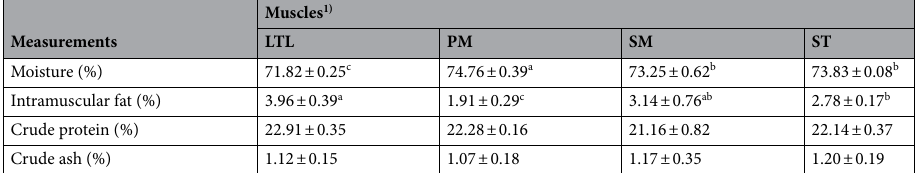
Table 1. Proximate composition of porcine skeletal muscles. a–c Means ± SE with different superscript within the same row are significantly different at P < 0.05. 1) LTL, M. longissimus thoracis et lumborum ; PM, M. psoas major ; SM, M. semimembranosus ; ST, M. semitendinosus.